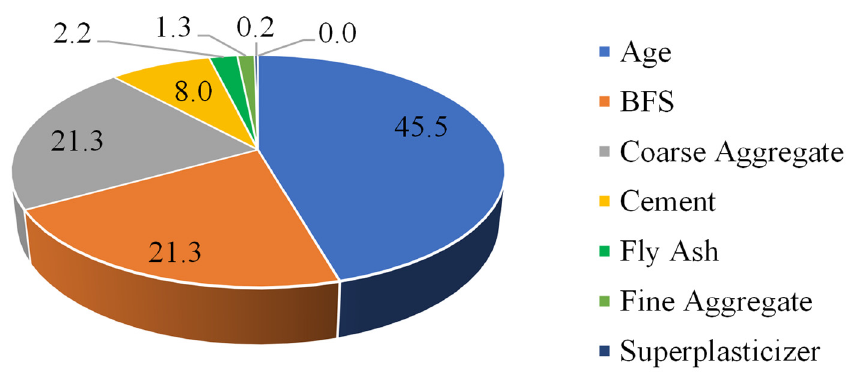
Figure 14. Relative contribution (%) of input variables in yielding compressive strength of green concrete.